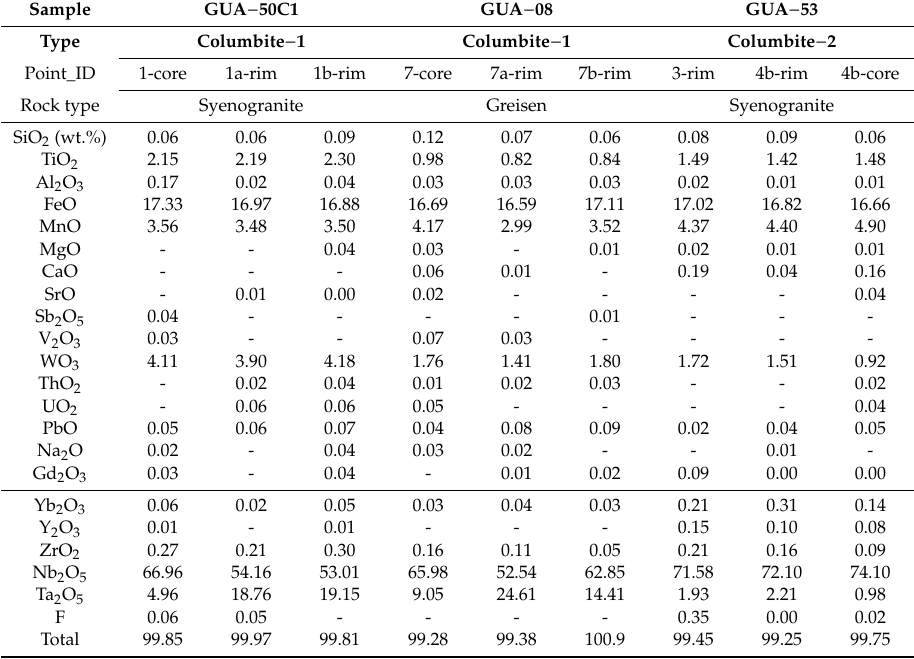
Table 2. Representative EPMA analysis of columbite crystals from the Desemborque Pluton.